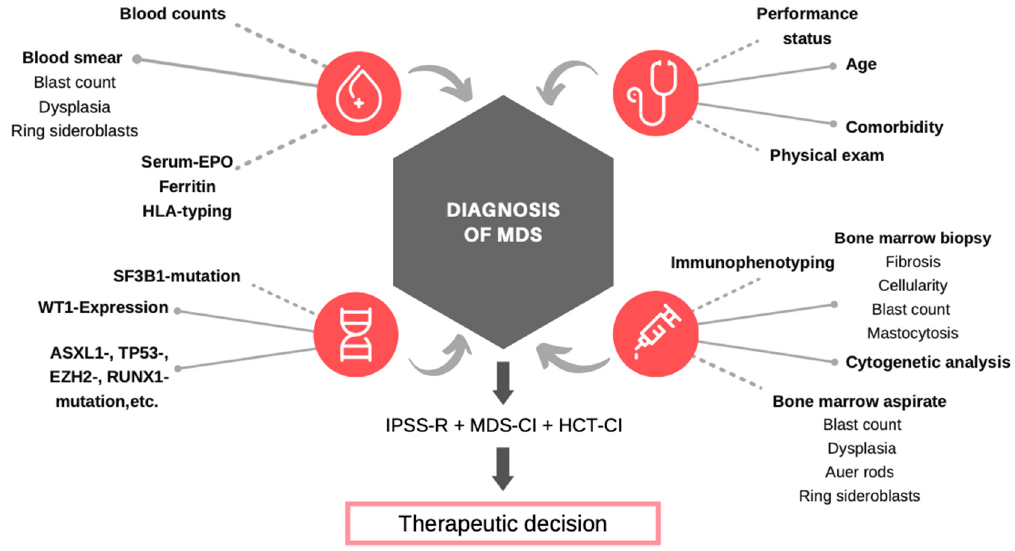
Figure 1. Overview of diagnostic tools for diagnosing MDS.